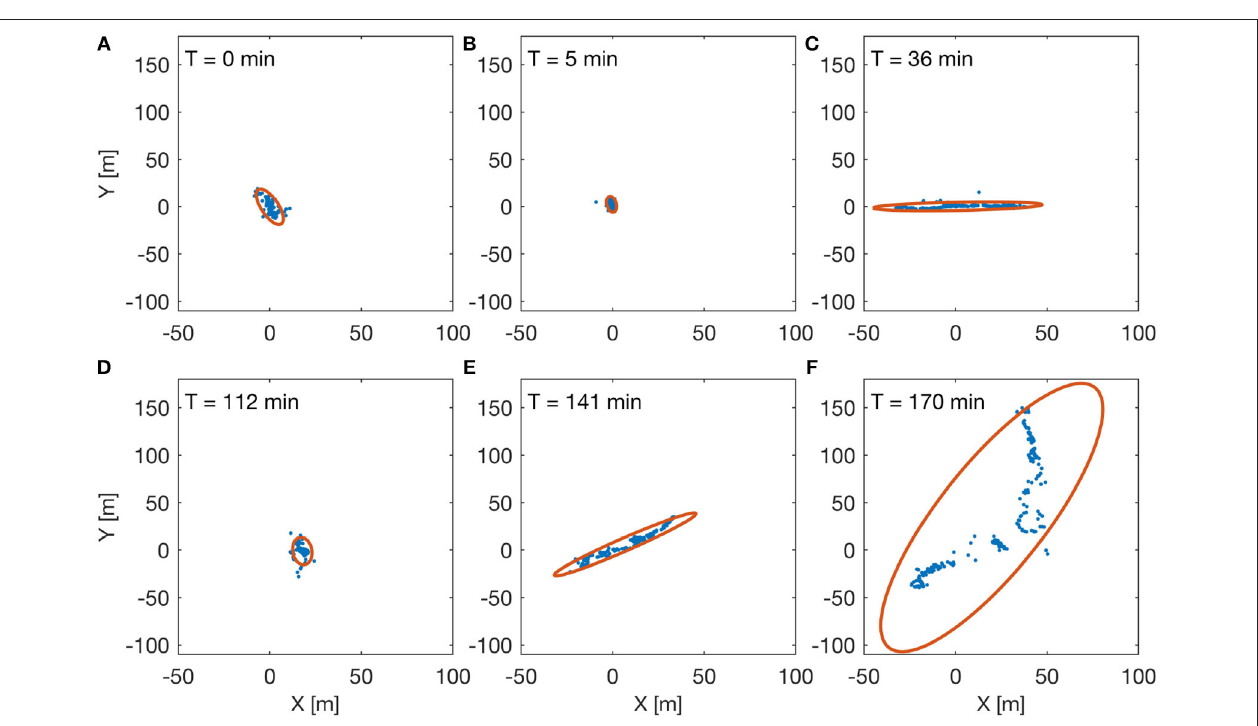
Frontiers in Marine Science |